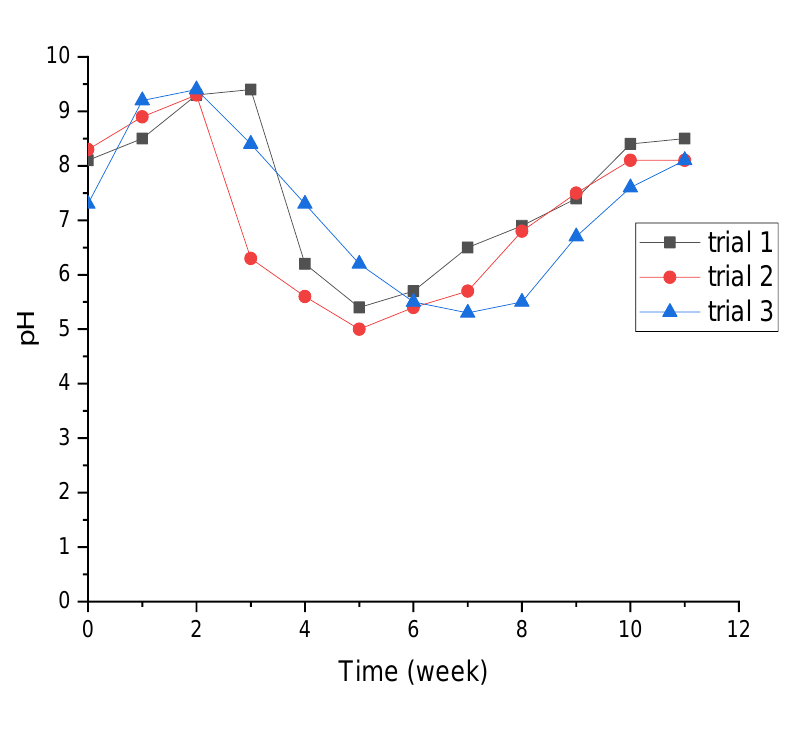
Fig. 5 pH of the composting trials Organic matter degradation of the composting trials The variation of organic matter degradation of compost trials 1, 2, and 3 are displayed in Fig. 7. The organic